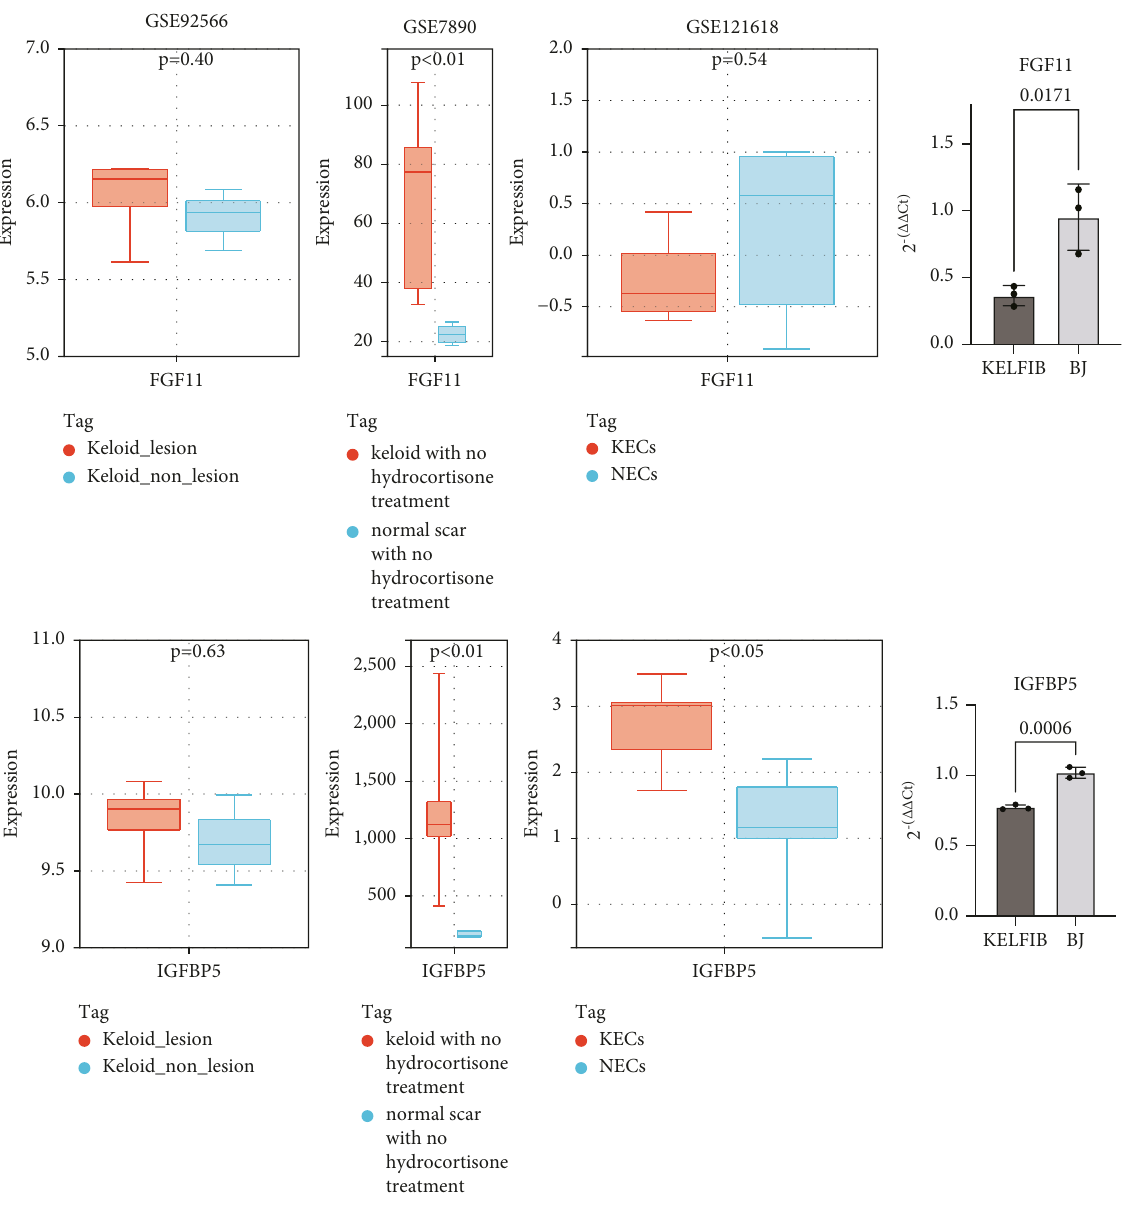
Figure 7: Expression levels of IGFBP5 and FGF11 in different datasets and verification by